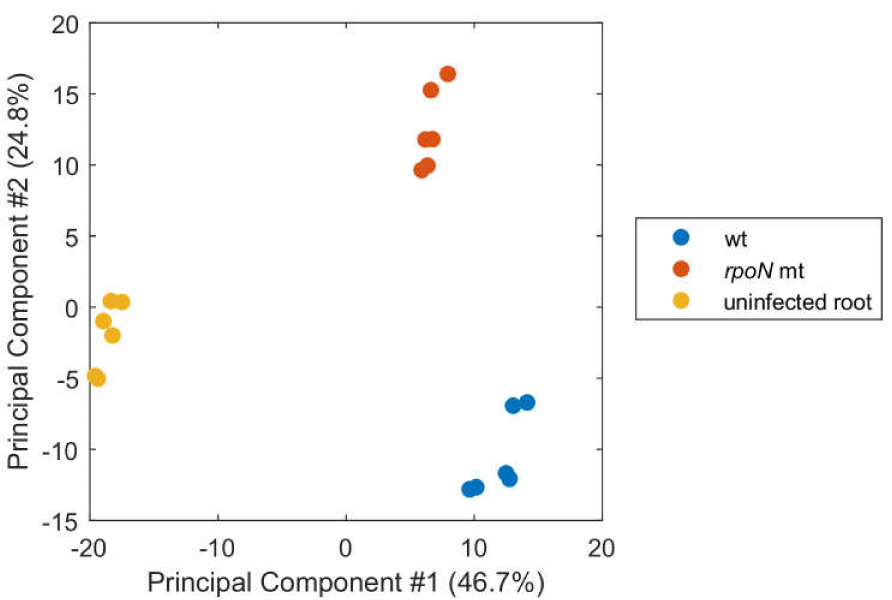
Figure 1. Principal component analysis (PCA) of metabolome datasets from P. vulgaris root nodules induced by wild-type P. phymatum (wt, blue) and rpoN mutant ( rpoN mt, red) strains, or from uninfected P. vulgaris roots (yellow). Three biological replicates were analyzed, each injected twice by non-targeted metabolomics; #: number.